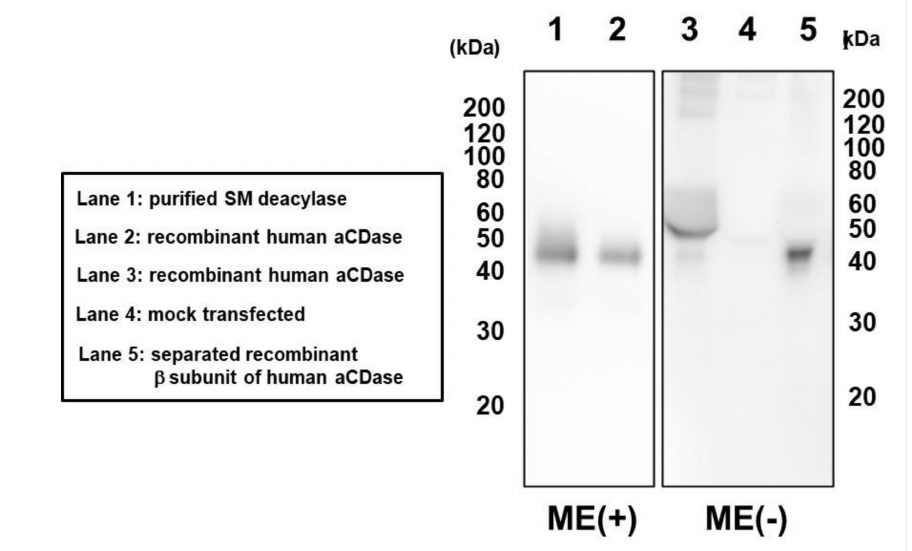
Figure 4. Subunit composition of purified SM deacylase recombinant human aCDase and separated recombinant β -subunitofhumanaCDase.